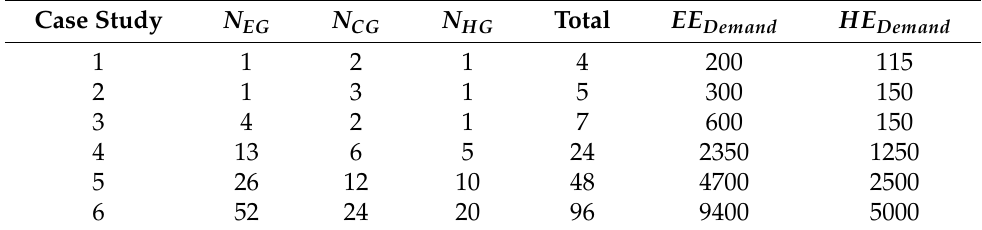
Table 3. Case Studies Data for solving CHPED Problem.